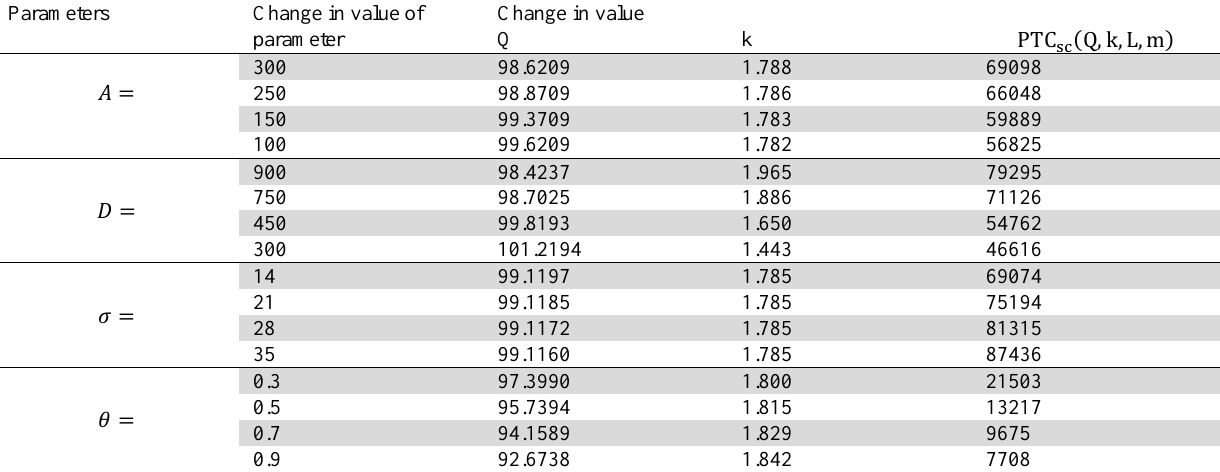
Sensitivity analysis for numerical example 1